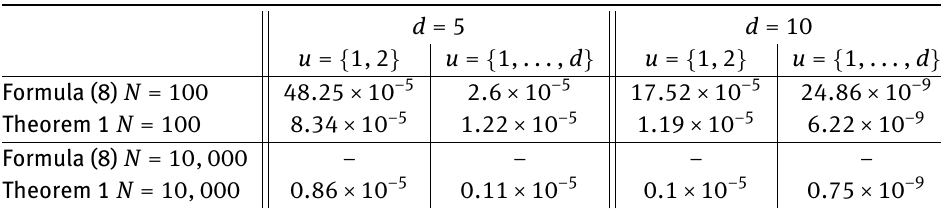
Table 1: AME for the estimation of σ 2 u when ψ ( x ) = max( x ) . Missing value – refers to exceeding the time limit.